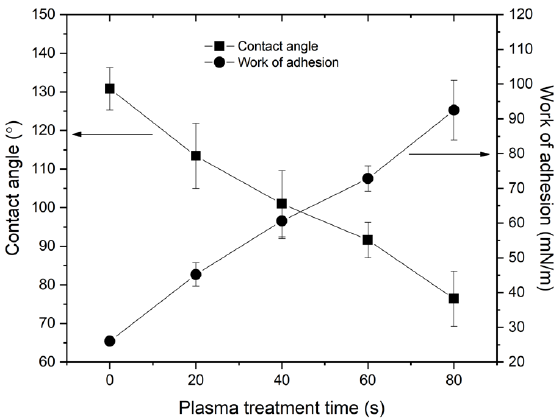
Figure 7. Contact angle and work of adhesion as a function of the plasma treatment time of broccoli seeds.